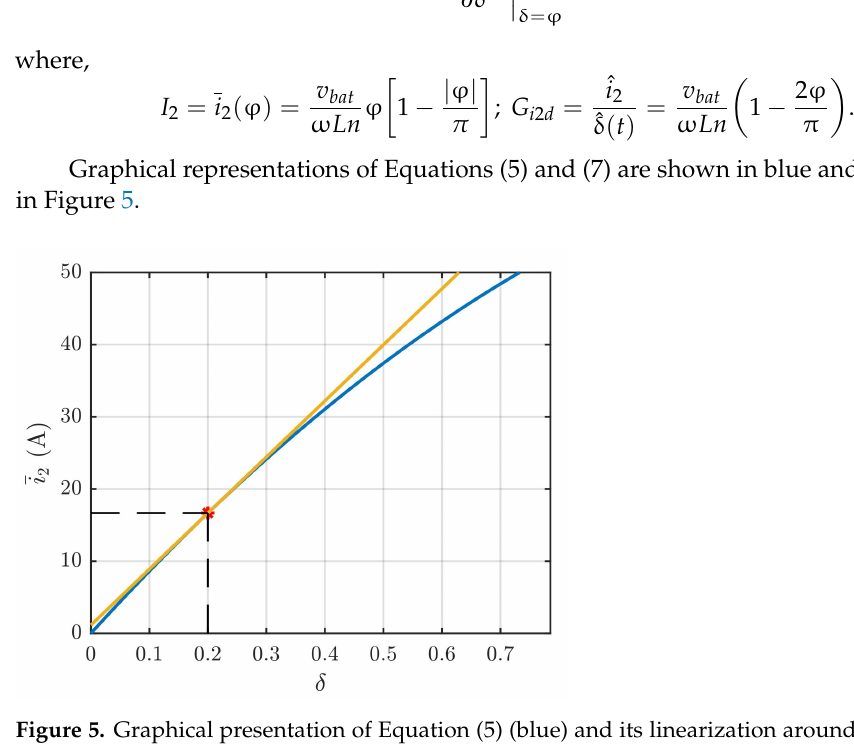
Figure 5. Graphical presentation of Equation (5) (blue) and its linearization around the operation point of Equation (7)